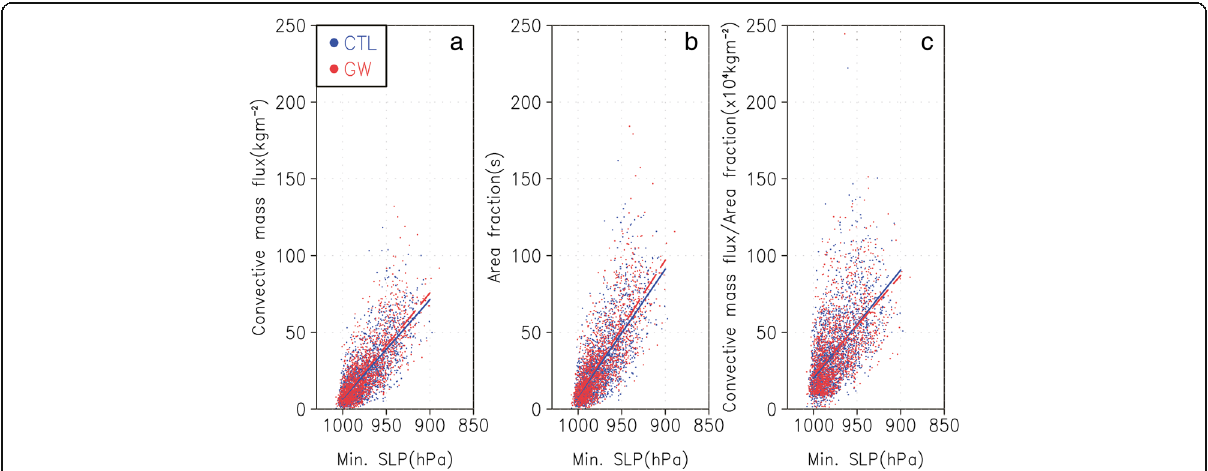
Fig. 13 Scatter plots of the TC properties versus the minimum sea-level pressure. Scatter plot represents a the relationship between the minimum sea- level pressure (Min. SLP) and the convective mass flux over the TC domain [ A ], b the relationship between the min. SLP and the fractional area of the strong updrafts [ B ], and ( c ) the relationship between the min. SLP and the area-averaged convective mass flux [ A / B ] for all the simulated TCs. The PD simulation is shown by blue dots and the GW simulation by red dots ; blue and red lines show regressions for the PD and GW simulations, respectively. The convective mass flux and the fractional area of the strong updrafts are accumulated for the lifetime of each TC, so that these have units of kg m -2 and s, respectively. Only the vertical velocities exceeding the threshold value of 0.5 m s -1 were used. The values at an altitude of 4 km are shown. After Fig. 5 of Satoh et al. (2015)